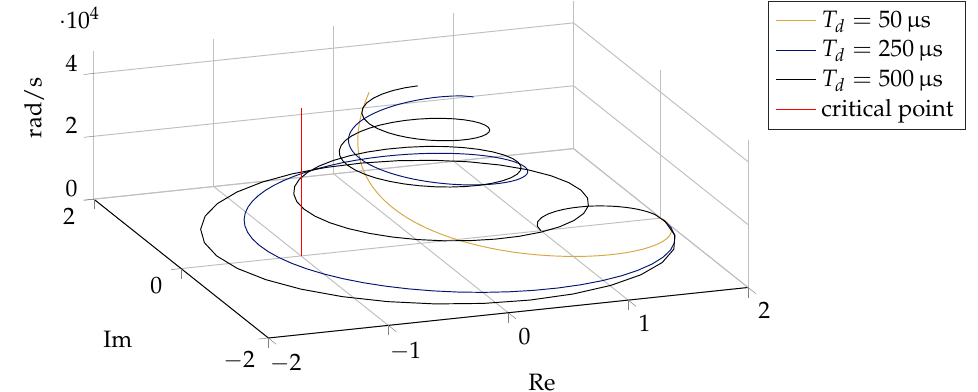
Figure 12. Locus plot of ITM PHiL in dependence of the loop time delay with the angular frequency as an additional dimension.